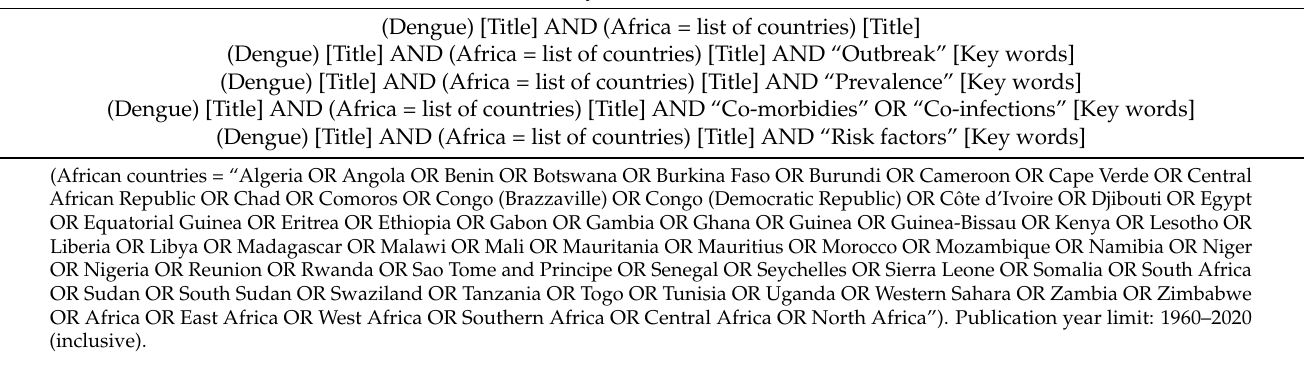
Table A1. Literature search strategy for studies included in the systematic review and meta-analysis. Search date: October to December, 2020. Key Search